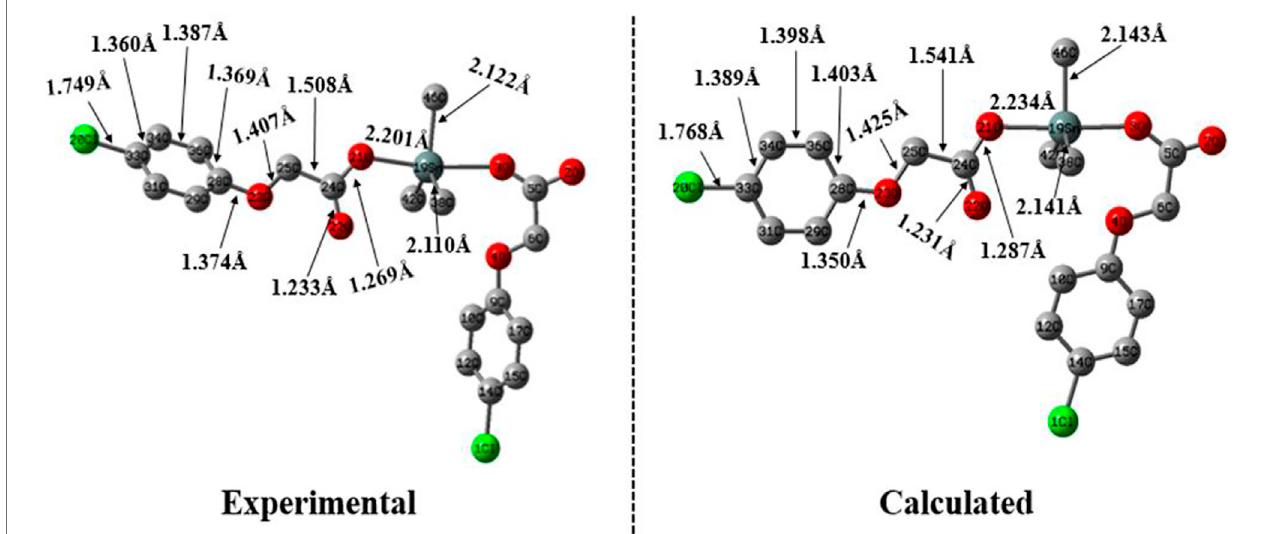
FIGURE 2 | The experimental and calculated geometry of complex 4 computed B3LYP/6-31G* + LANL2DZ basis set.